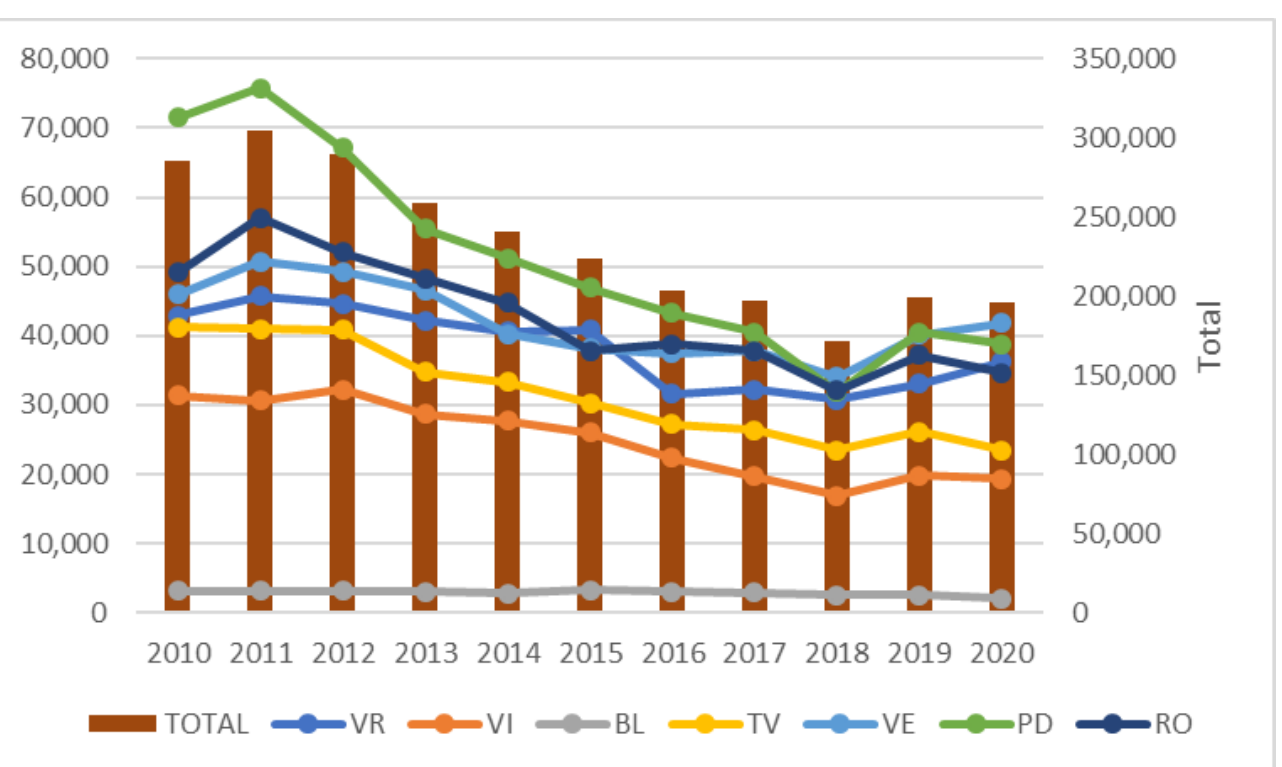
Figure 5. Maize cultivation land (ha) areas in the Veneto provinces from 2010 to 2020 (Source: Veneto Agricoltura 2021 [43]) (VR: Verona; VI: Vicenza; BL: Belluno; TV: Treviso; VE: Venezia; PD: Padova; RO: Rovigo).